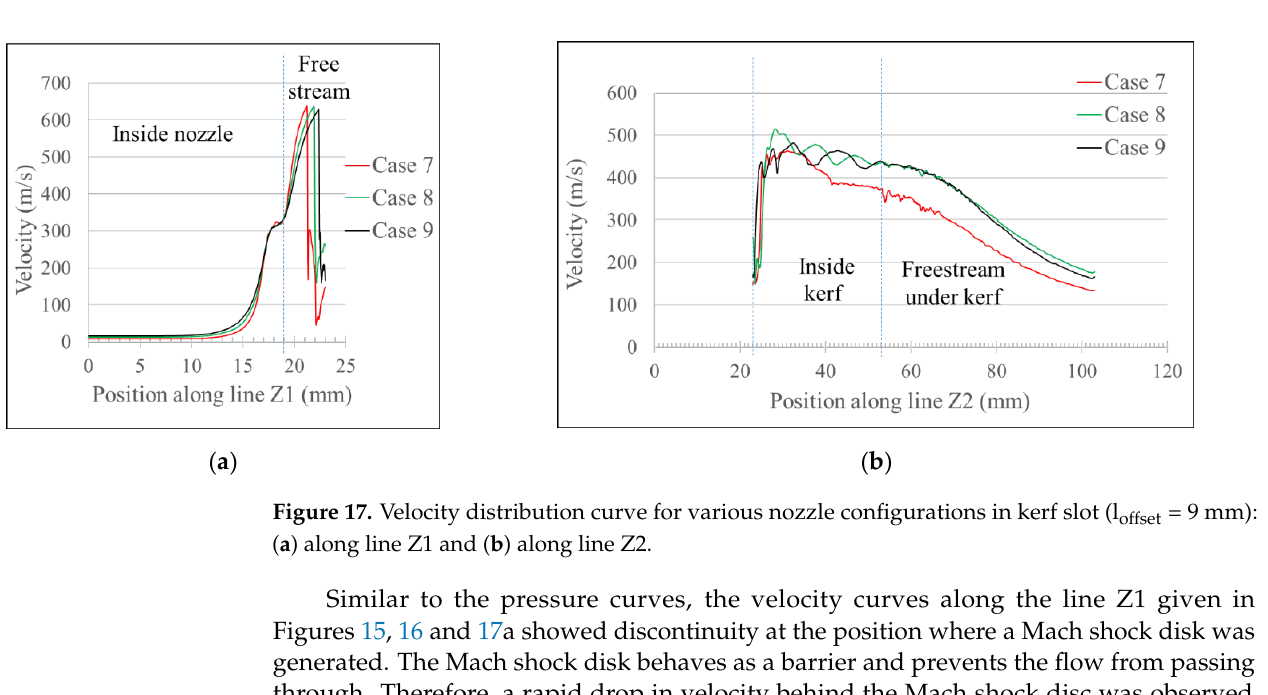
Figure 16. Velocity distribution curve for various nozzle configurations in kerf slot (l offset = 6 mm): ( a ) along line Z1 and ( b ) along line Z2.